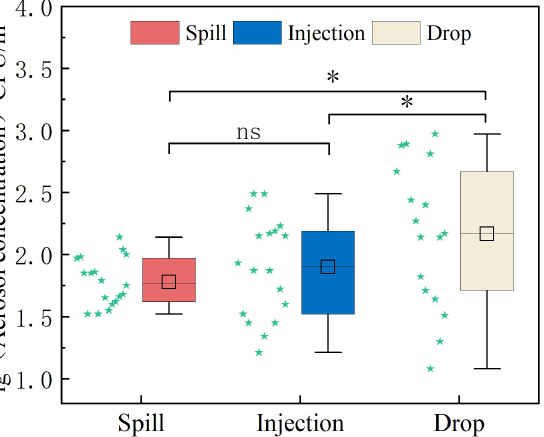
Figure 3. Relationship between aerosol concentration and experimental risk factors. * p < 0.05, the statistically significant difference in aerosol concentration among the three risk factors; ns, no statistical difference (one-way ANOVA test).